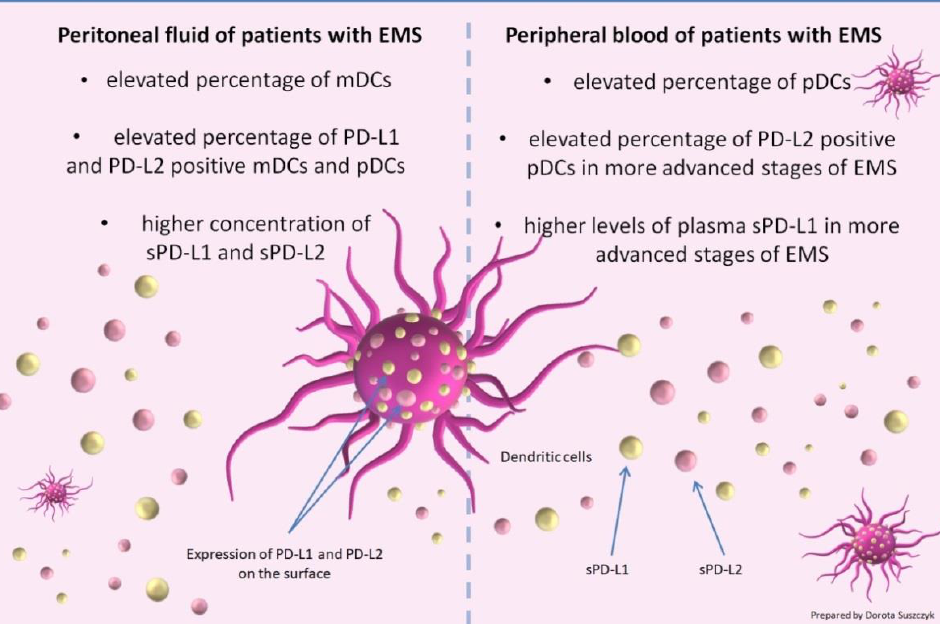
Figure 11. Summary of the most important points of the study.